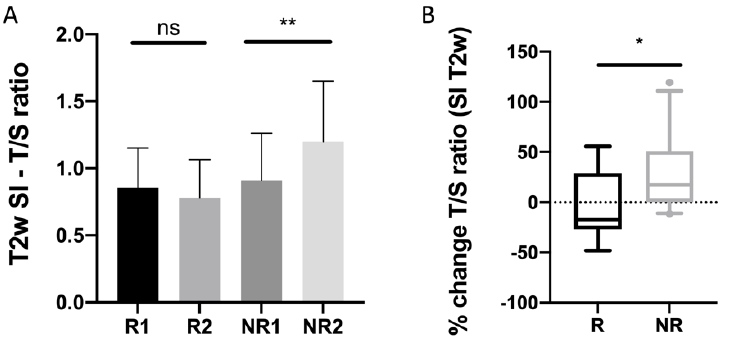
Figure 5. ( A ) T/S ratio of non-enhanced T2w SI of NELMs before and after treatment start. ( B ) Per- centual changes of T/S ratio of NELMs. Asterisks indicate statistical significance (* p ≤ 0.05, ** p ≤ 0.01).